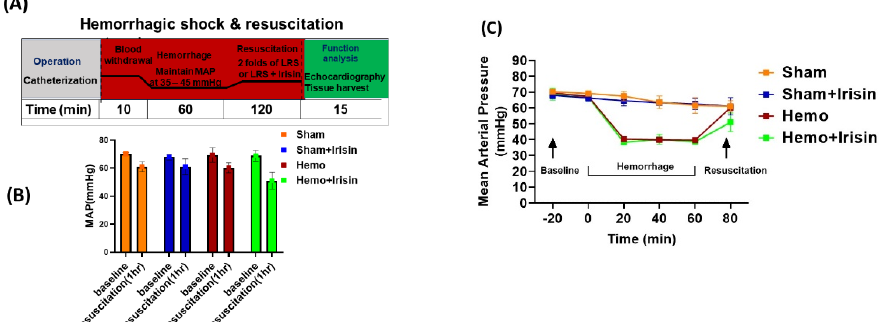
Figure 1. Time course and experimental protocol for the hemorrhagic shock model. ( A ) BP of mice were maintained at 35-45 mmHg of mean arterial blood pressure (MAP) for one hour before fluid resuscitation with lactated ringer’s solution (LRS) in hemorrhagic shock groups. Irisin treatment was conducted simultaneously with resuscitation. The sham groups underwent operation without blood withdrawal; ( B ) MAP of animals while in hemorrhagic shock (Data are shown as Mean ± SEM, n = 4/each group); ( C ) The time course of MAP during the hemorrhage.